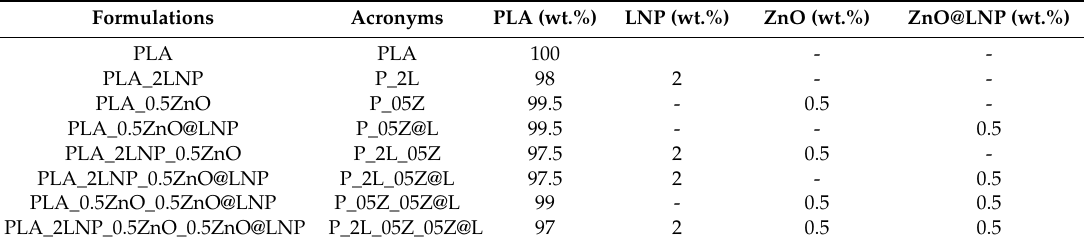
Table 1. Material